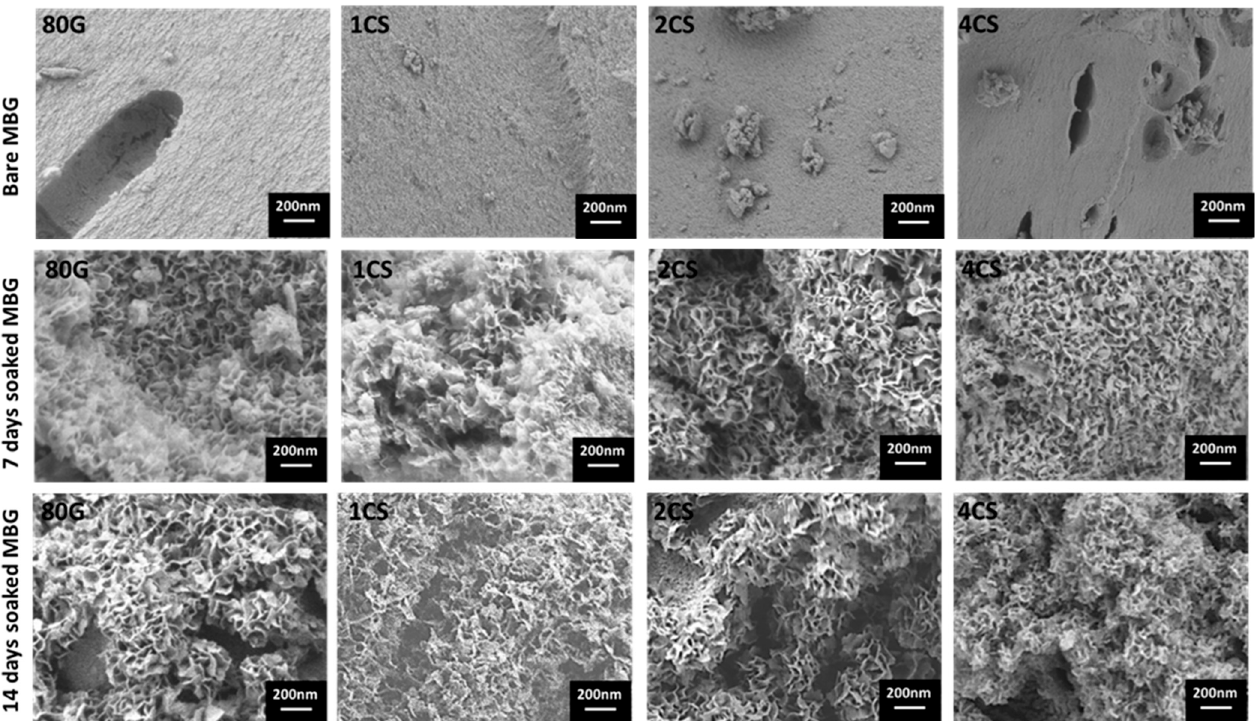
Figure 8. FESEM images of bare MBG powders and after SBF soaked (7 and 14 days) MBG powders.